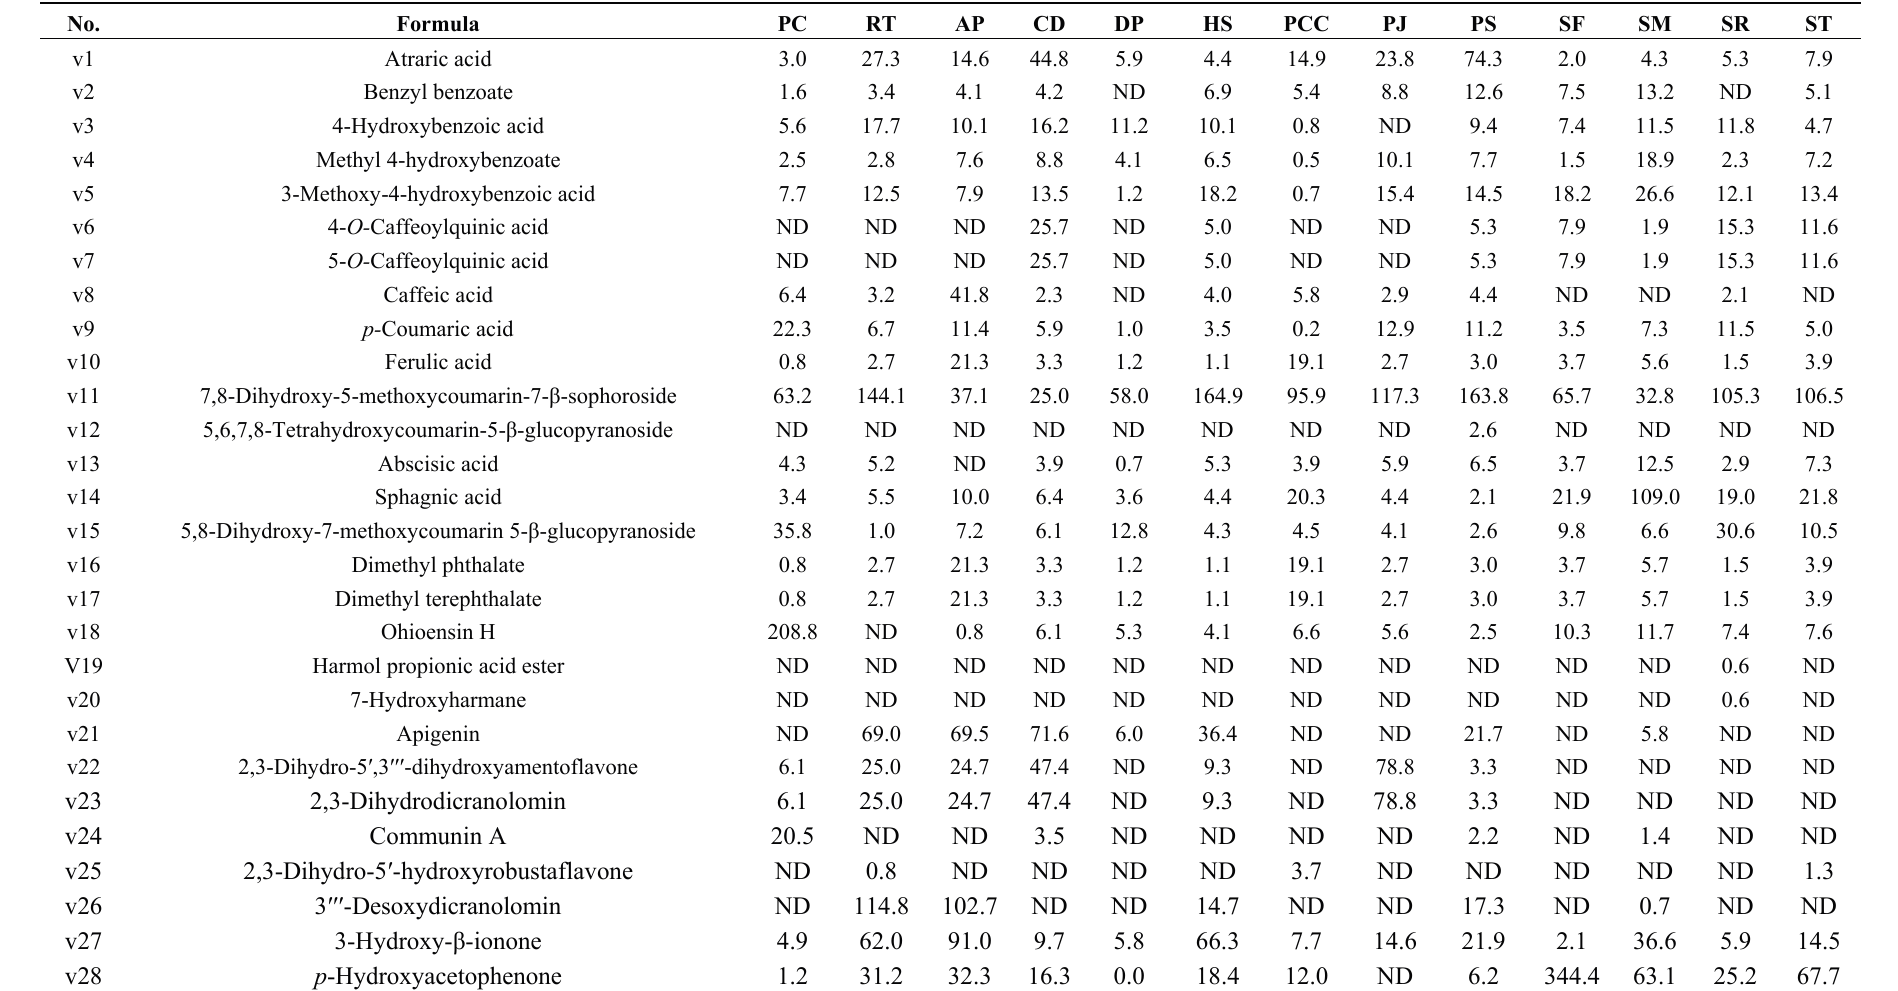
Table 5. Data of the LC-TOF-MS analysis of moss ethanol